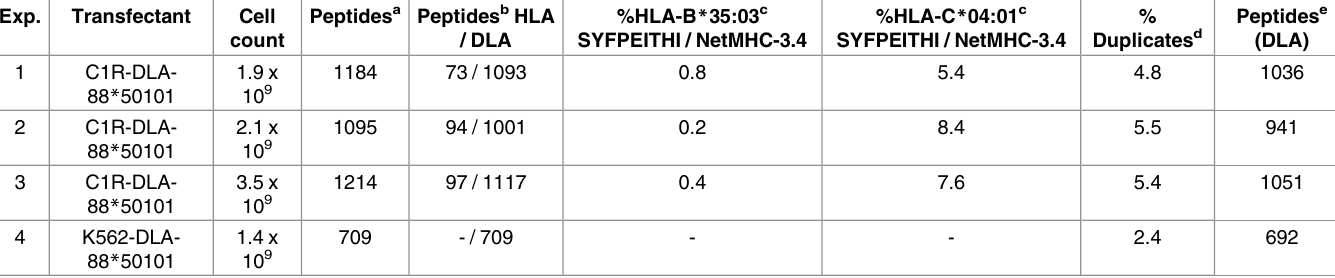
Table 1. Summaryof MHC class I immunoaffinity purification assay of C1R and K562 cells transfected with DLA-88 * 50101.